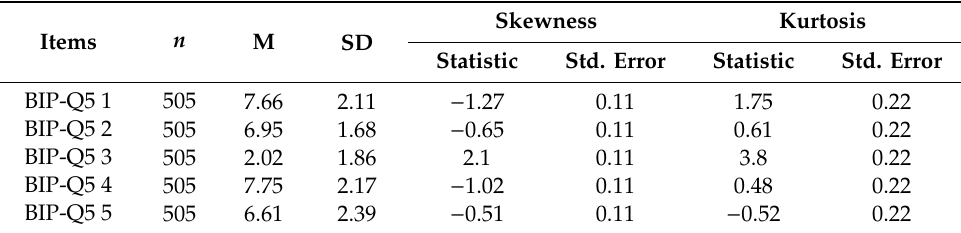
Table 1. Descriptive statistics. Calibration sample ( n =